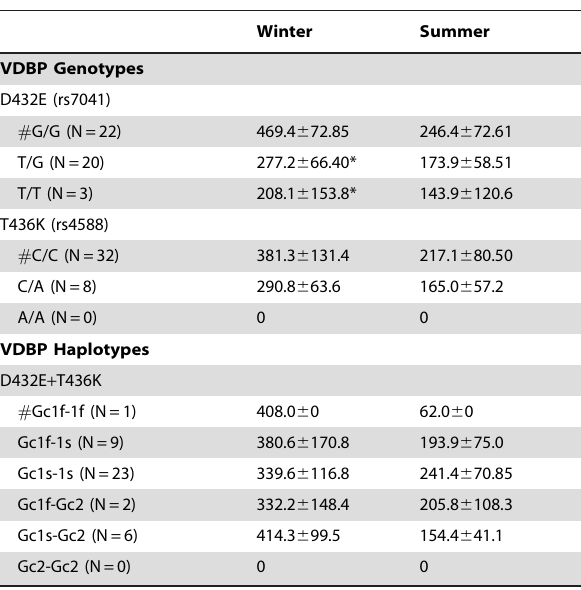
Table 3. Vitamin D binding protein serum concentrations (ug/ml) stratified by vitamin D binding protein genotypes (mean 6 standard